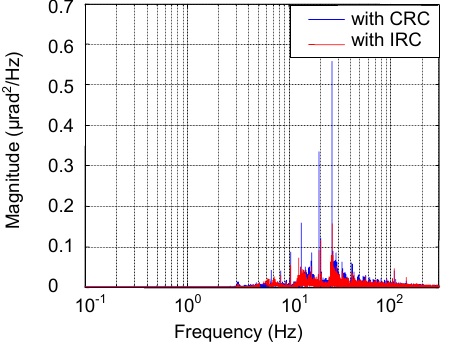
Fig. 15 | Spectra of Tip-Tilt vibrations with CRC and